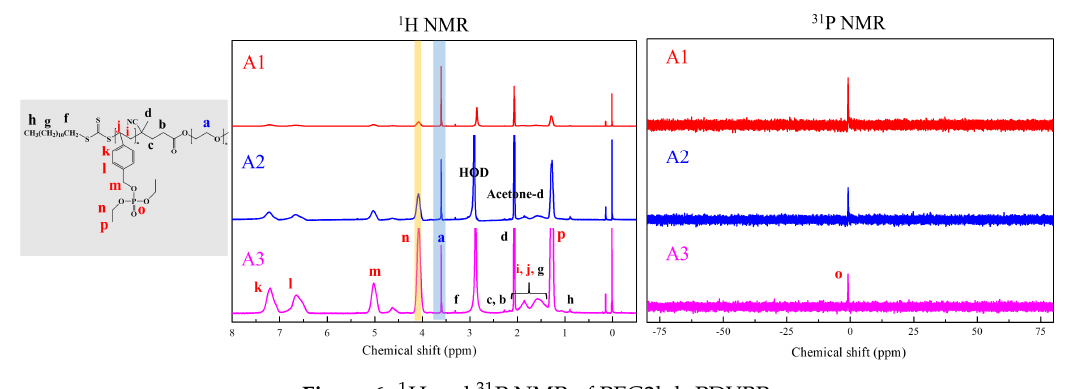
Figure 6. 1 H and 31 P NMR of PEG2k-b-PDVBP.